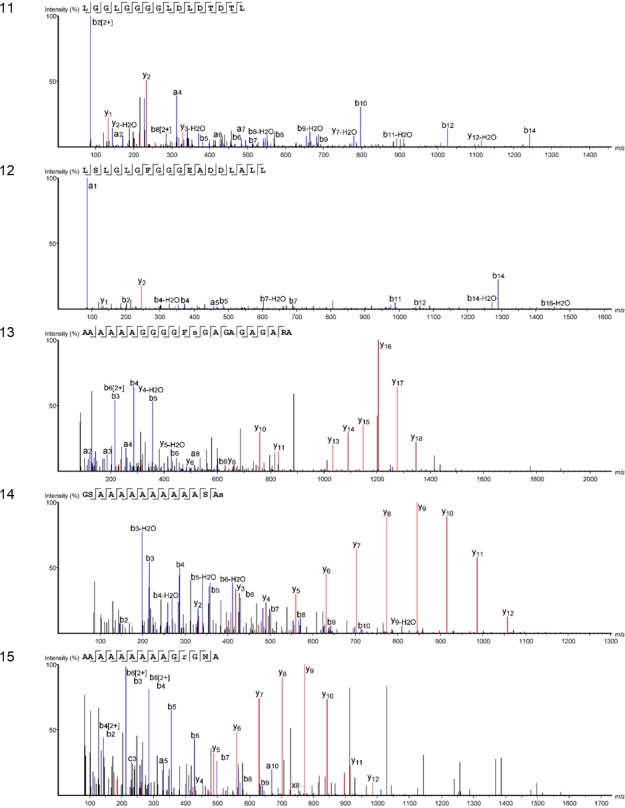
Product ion spectra [11 - 15] supporting the coverage of protein Hic74 identified in the double-button HavC.